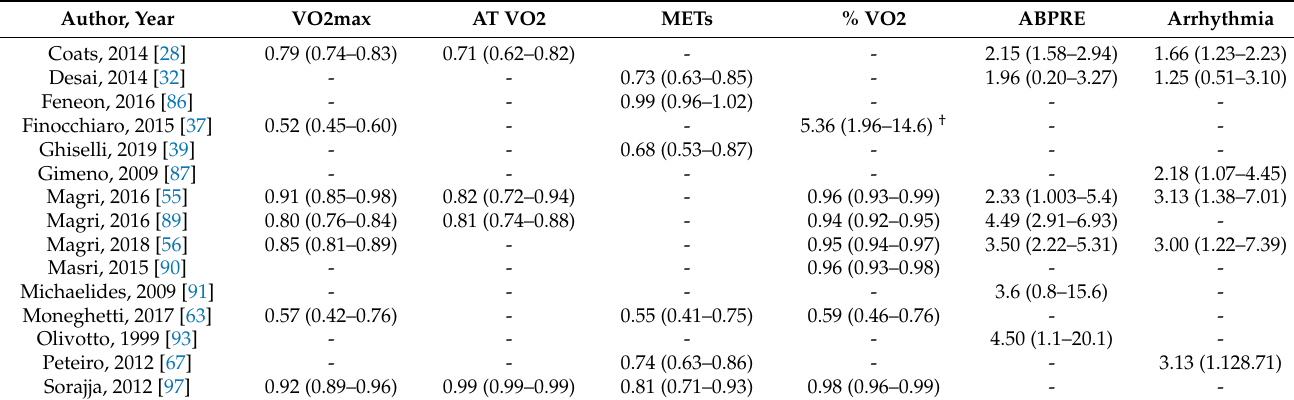
Table 3. Univariate hazard ratio of functional assessment derived parameters for composite